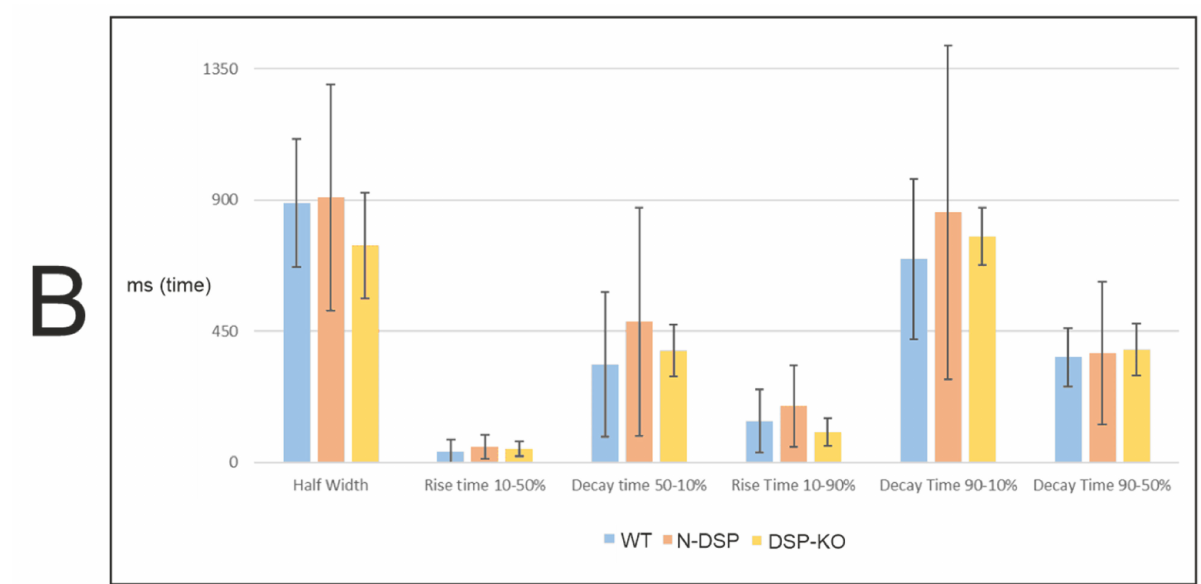
Figure 7. Calcium imaging peaks ( A ) and studied parameters ( B ) of the DSP clones. The black arrow in section A indicates the pulse of